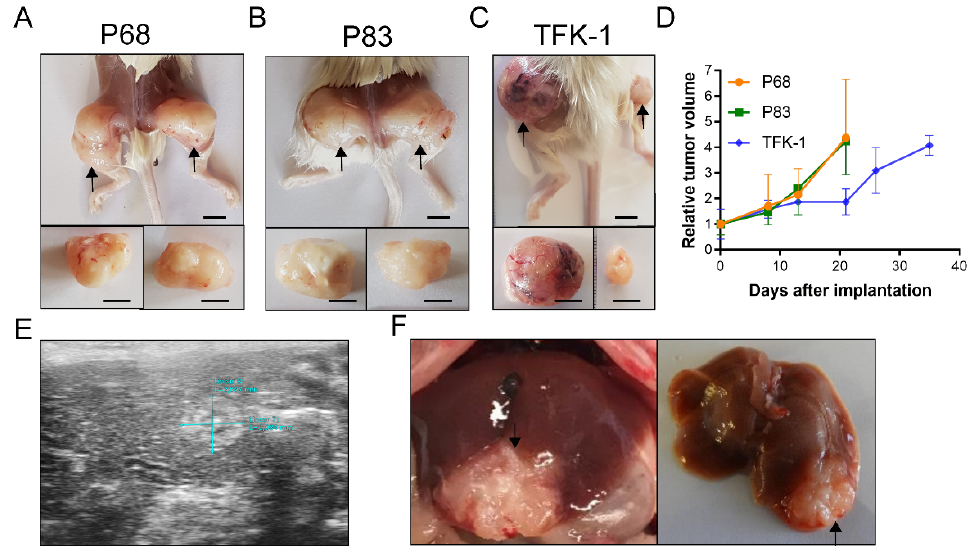
Figure 2. Organoid-derived in vivo xenograft experiments. Top row: Mice with bilateral tumors after subcutaneous injec- tion of PDOs. Pictures from the time point of sacrifice are shown: ( A ) P68; ( B ) P83; ( C ) TFK-1. Scale bar, 5 mm. ( D ) Growth curve of three different organoids in subcutaneous xenografts (n = 3). Bottom row: Orthotopic injection of patient-derived organoids in the left liver lobe. ( E ) Ultrasound confirmation of orthotopic tumor formation. ( F ) Orthotopic tumors after dissection.